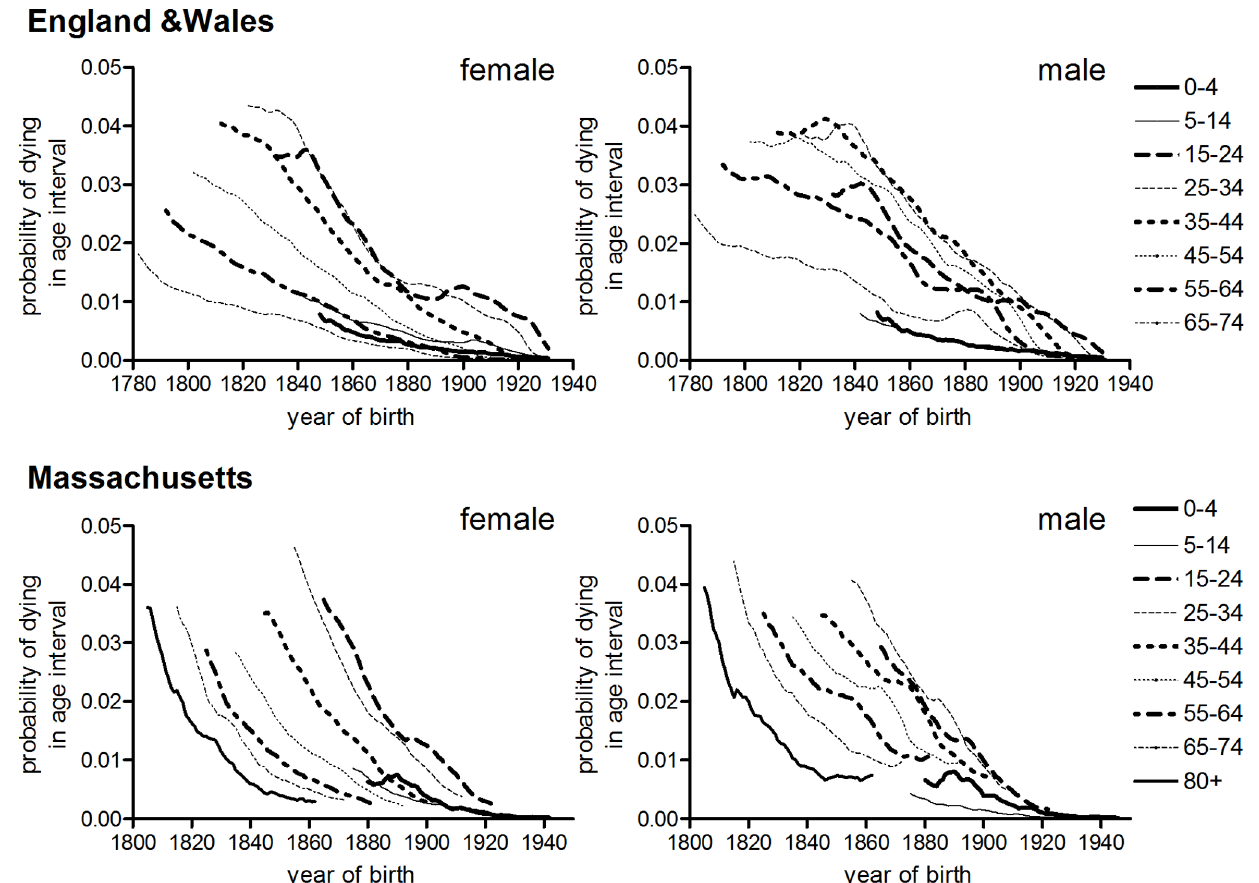
Figure 8. Age-specific respiratory tuberculosis mortality by birth cohort. Rates for years after 1945 were excluded.